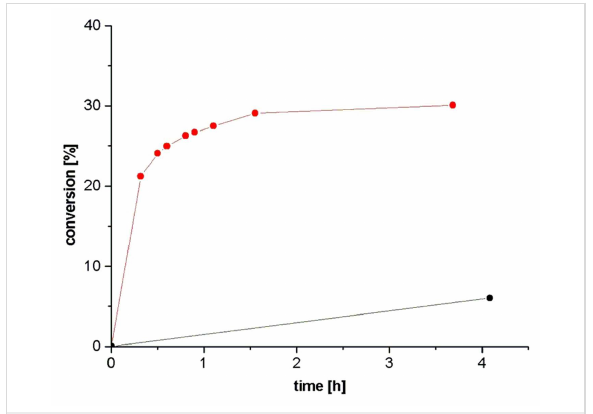
tion times. Best results, 96% yield and 36% ee with only 10 mol% of catalyst, were found at −40 °C (Table